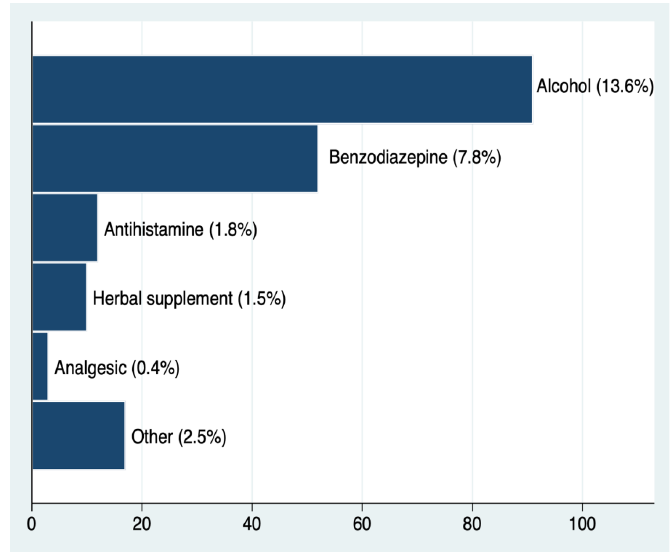
Figure 1. Sleep-aid use